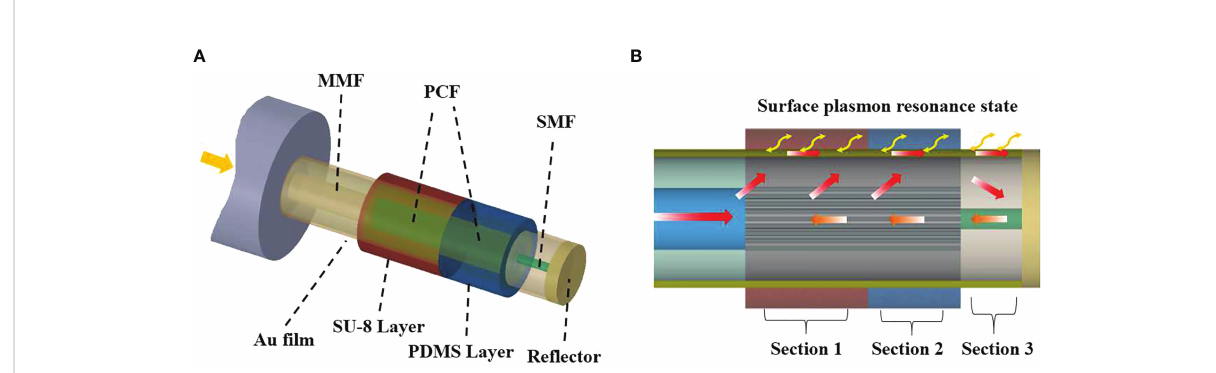
FIGURE 7 Schematic of the SPR sensing principle tested by Zhao et al, 2019. It is composed of a combined re fl ective structure with multi-mode fi ber (MMF), photonic crystal fi ber (PCF) and single-mode fi ber (SMF) (A) . (B) , illustration of the SPR effect (from Zhao et al,